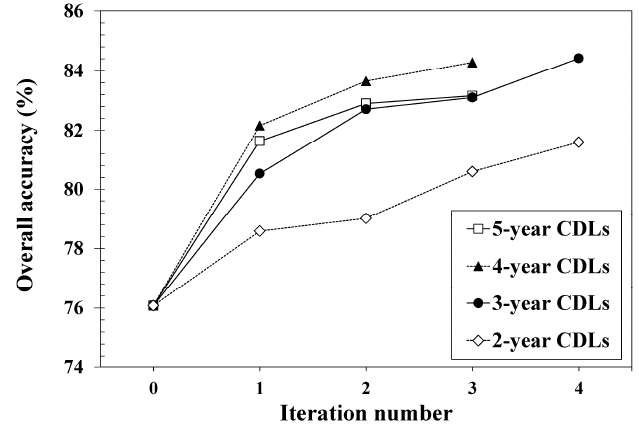
Figure 7. Overall accuracy versus the iteration number for the four different CDL combination cases. Iteration 0 indicates the initial classification.